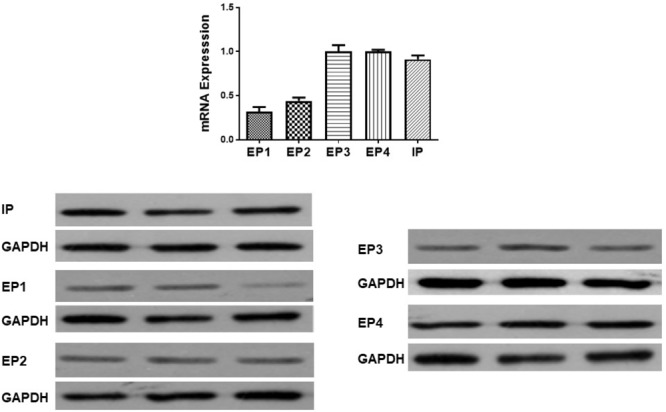
Gene and protein expression of prostanoid receptors in non-pulmonary hypertension rats. Pulmonary artery tissues were obtained from the third and subsequent bifurcations. The (upper panel) shows relative mRNA expression using primers shown in Supplementary Table S1. The (lower panel) shows Western blots of protein expression. A different gel was used for each receptor and the respective GAPDH band is shown for each. Gels were analyzed with a Biorad Universal Hood II Molecular Imager Gel System.